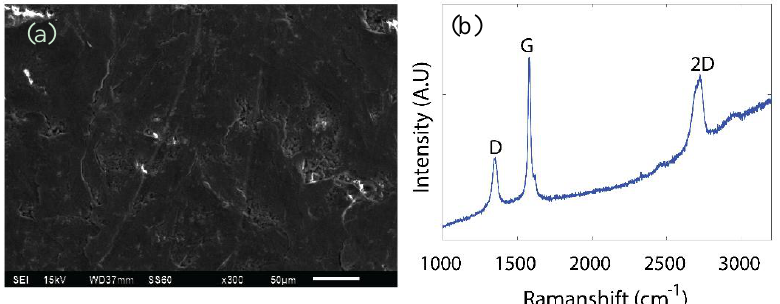
Figure 4. ( a ) Scanning Electron Microscopy (SEM) image of GoP, ( b ) Raman spectrum of GoP.